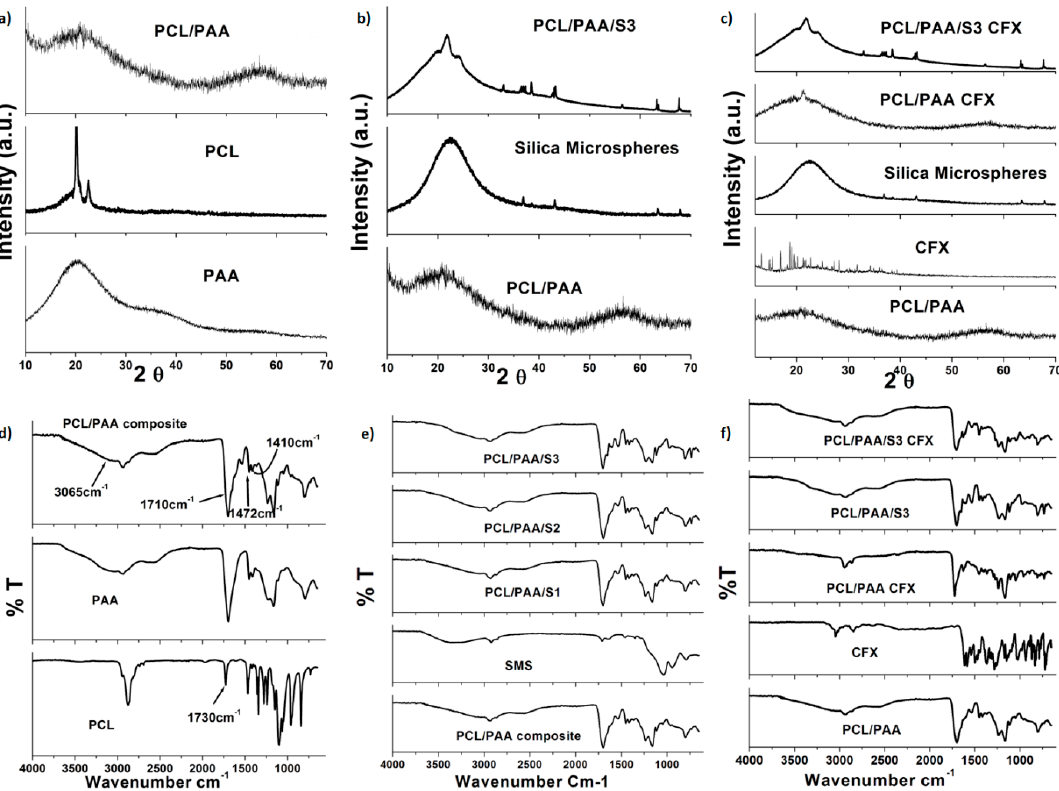
Figure 3a. This result confirmed the homogenous dispersion of PCL into the PAA network. Moreover, the loading of Si microspheres and CFX was confirmed by the XRD patterns of PCL/PAA/S3 and PCL/PAA/S3/CFX blends presented in Figure 3b,c. These curves directly verify the